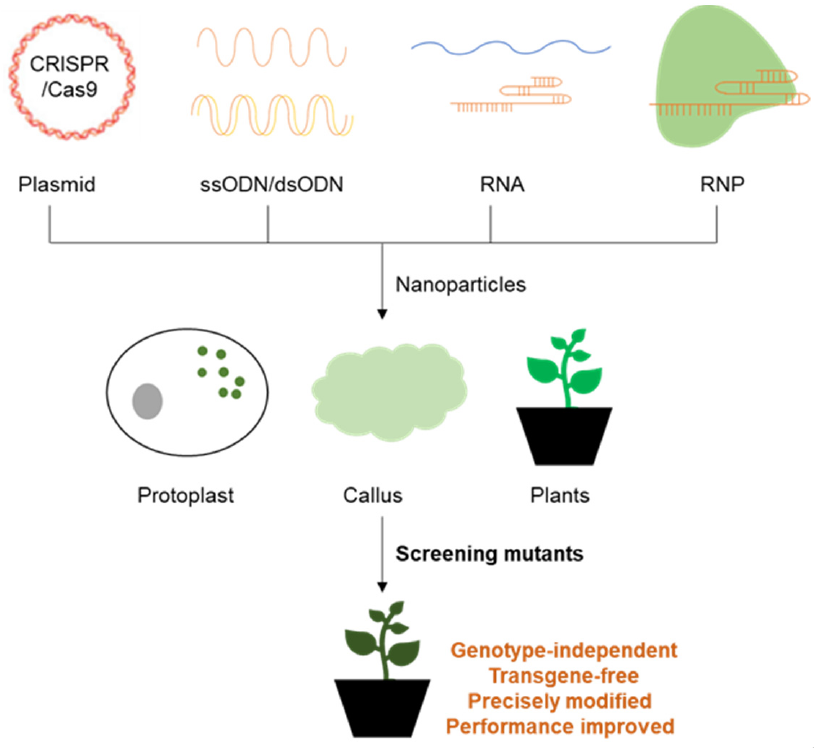
Figure 4. The promising application of nanomaterials in plant genome editing. The ability of nanomaterials in delivering all types of cargos, including plasmids encoding the CRISPR/Cas system, single-strand and double-strand oligo donor (ssODN and dsODN), RNA and ribonucleoproteins (RNPs), makes them quite promising in plant genome editing, since traditional delivery methods can only deliver certain types of cargos or have other drawbacks. These nanomaterials could be directly used to transform protoplasts, callus, and plants, and precisely edit the genome. New selection and transformation methods are needed to screen and finally obtain the mutant plants. These methods are genotype independent, we can acquire new plant varieties without integration of exogenous DNA, and the genome can be precisely modified as we wish, to achieve better performances in the field and ensure food